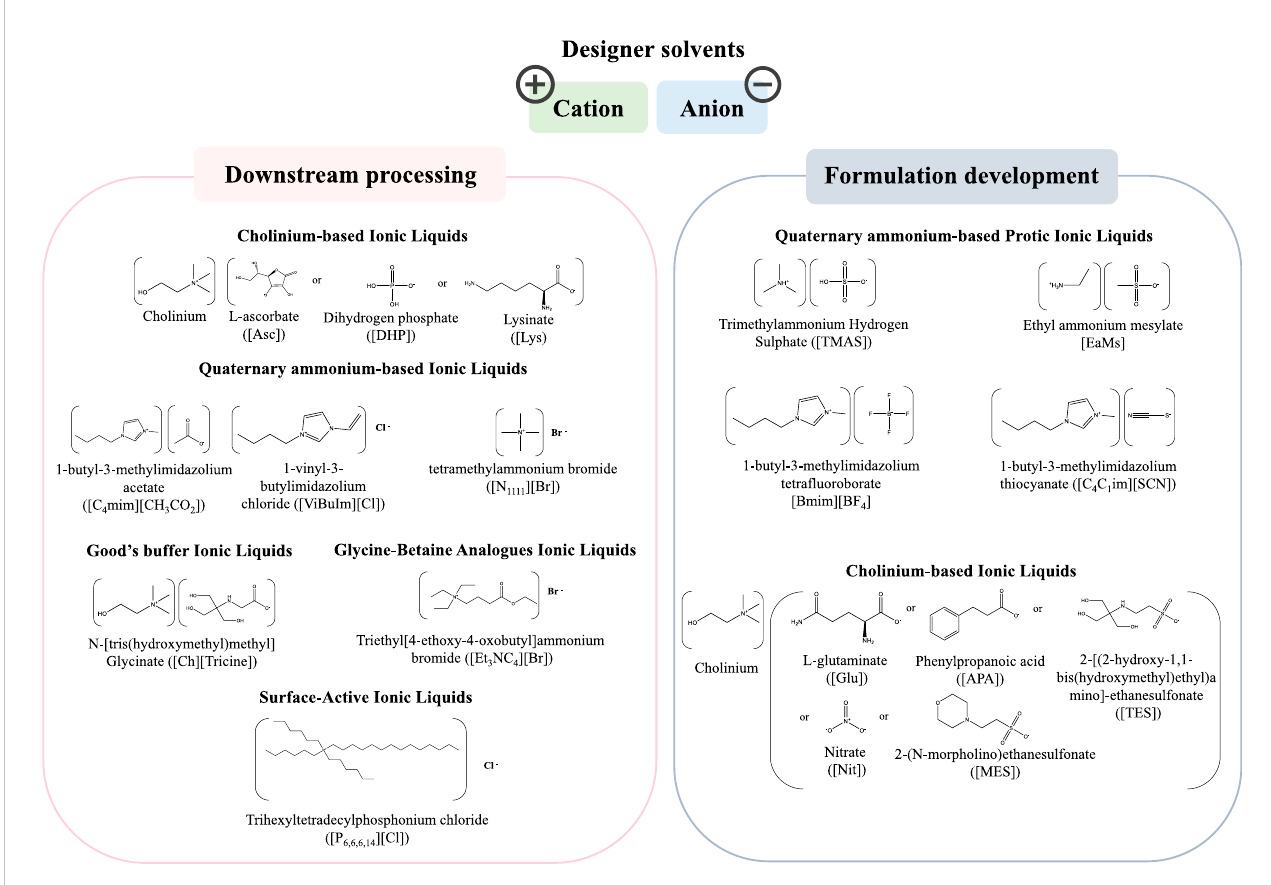
FIGURE 4 Chemicalstructures andnomenclatureofrepresentativeILsusedinthebiopharmaceutical fi eld,namelyinthedownstreamprocessingandformulation.